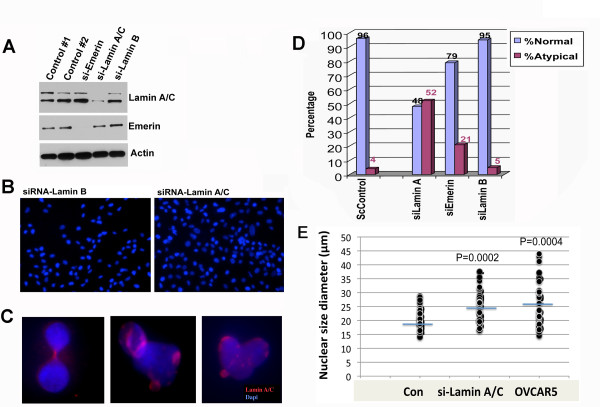
Suppression of lamin A/C expression in ovarian surface epithelial cells leads to a deformed nuclear shape. Primary HOSE cells were treated with siRNA to lamin A/C for three days and were analyzed for the effect on nuclear size and morphology. (A) Western blot shows the specific suppression of protein by siRNA to emerin, lamin A/C, and lamin B1 in primary HOSE cells. (B) A low magnification image (× 200) shows the presence of a high percentage of cells with large and deformed nuclear morphology following suppression of lamin A/C by siRNA in primary HOSE cells for three days. Suppression of lamin B had no significant effect on nuclear morphology. (C) Examples shown at high magnification (× 1,000) of individual deformed nuclei with reduced and patchy lamin A/C staining. (D) The nuclear morphological abnormality was scored by computer-assisted image analysis. About 100 nuclei in each group treated by siRNA were analyzed and the percentage of normal and atypical nuclear morphology is shown. ScControl: scrambled controls. (E) The nuclear size/diameter was scored by computer-assisted image analysis (AxioVision software 4) following shRNA treatment for 3 days. Nuclear sizes were plotted following computer-assisted imaging analysis of 50 nuclei randomly selected from each group, compared to OVCAR5 ovarian cancer cells.